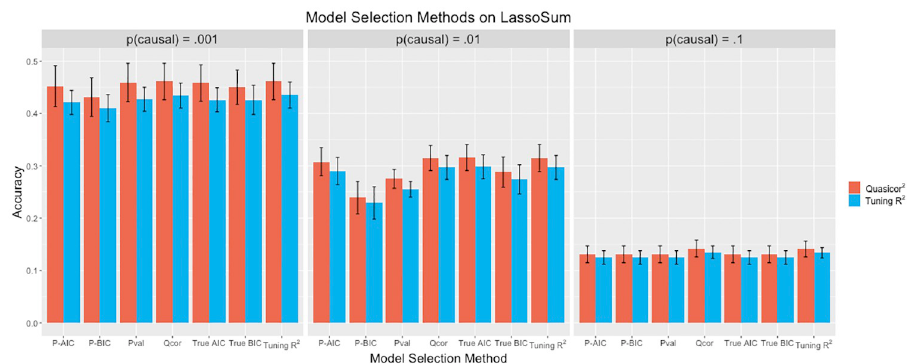
Fig 9. Performance of the seven different model selection methods applied to a set of candidate LassoSum models. Performance is measured by r 2 on the testing data (the right bar in each group), and by squared quasi-correlation on the testing data (the left bar in each group). Error bars represent the standard deviation across 20 replications.